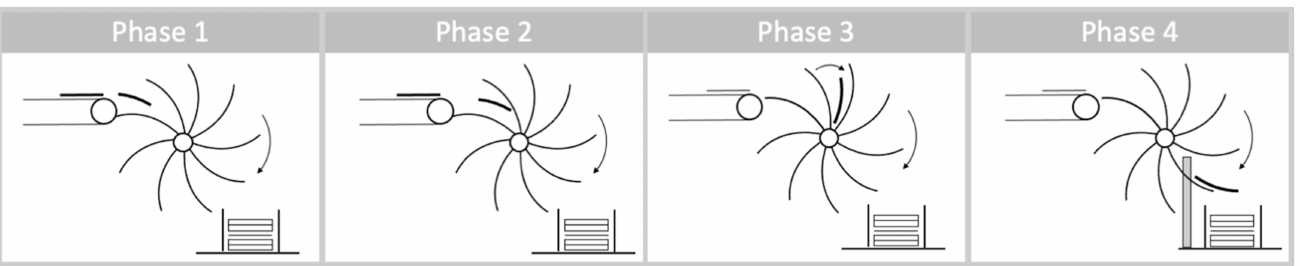
Figure 8. Process phases of the handling process in the paddle